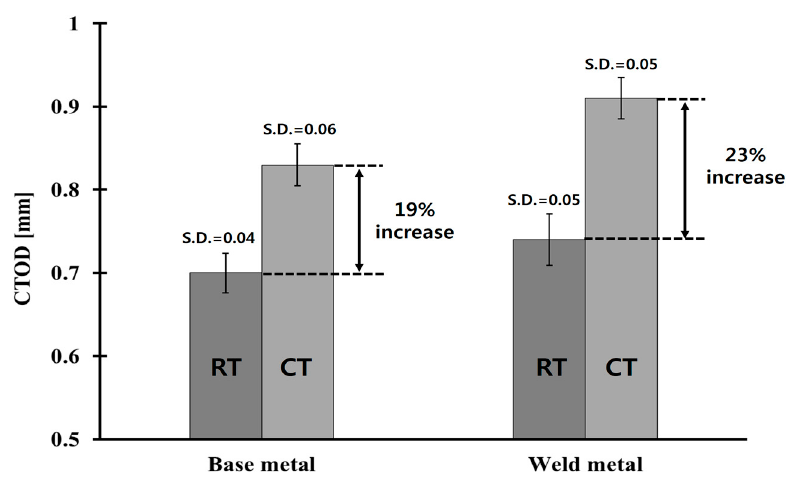
Figure 6. CTOD improvement ratio from room to cryogenic temperatures.